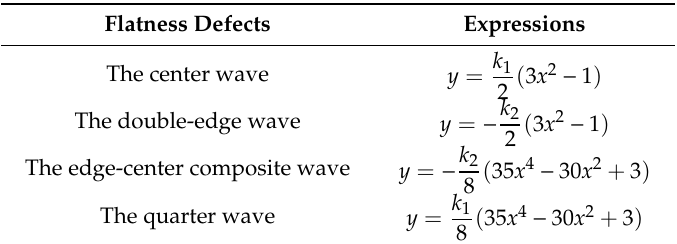
Table 2. Expressions of uneven